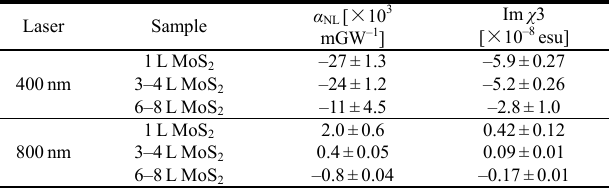
Table 1 Linear and NLO parameters in monolayer and few-layer MoS 2